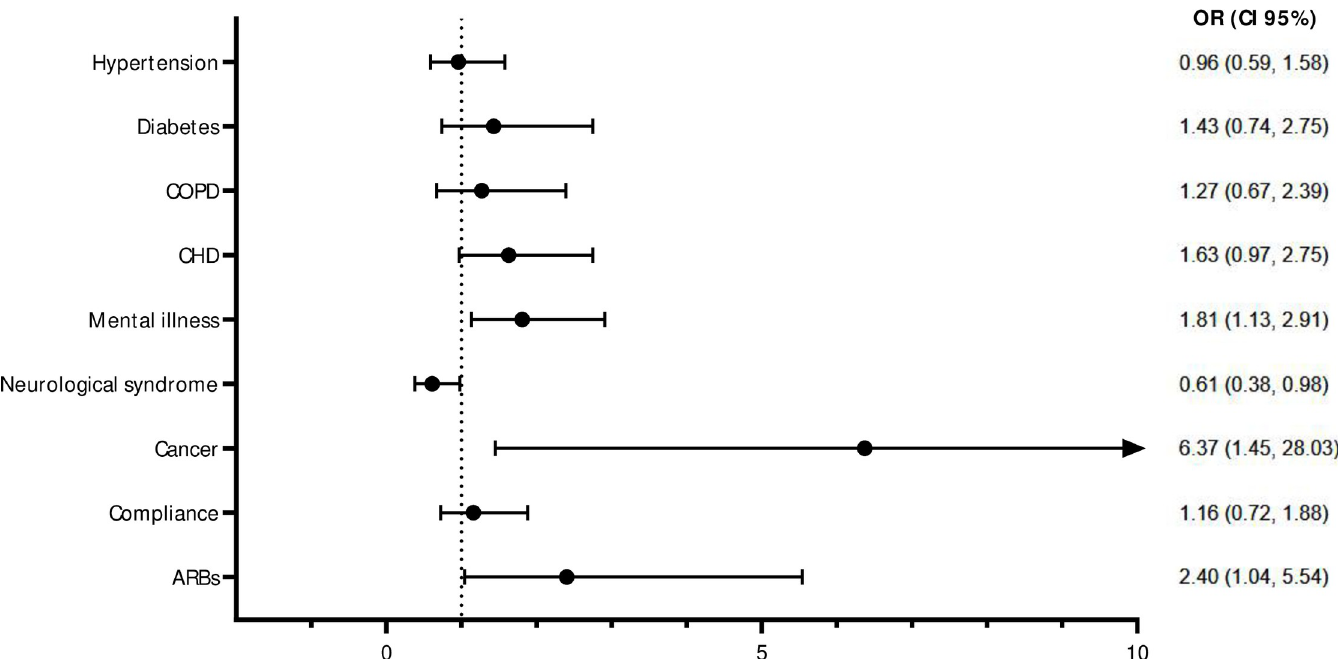
Fig 1. Forrest Plots of multivariate logistic regression estimates of factors associated with SARS-CoV-2 infection. Multivariable model includes all variables selected by a backward selection that were retained with a p-value less than 0.2 level. OR: Odds Ratio; CI: Confidence Interval; COPD: chronic obstructive pulmonary disease; CHD: cardiovascular disease; ARBs: Angiotensin II receptor